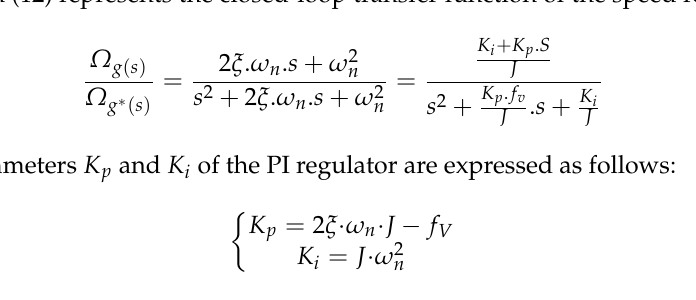
Figure 4. Typical PI controller structure.